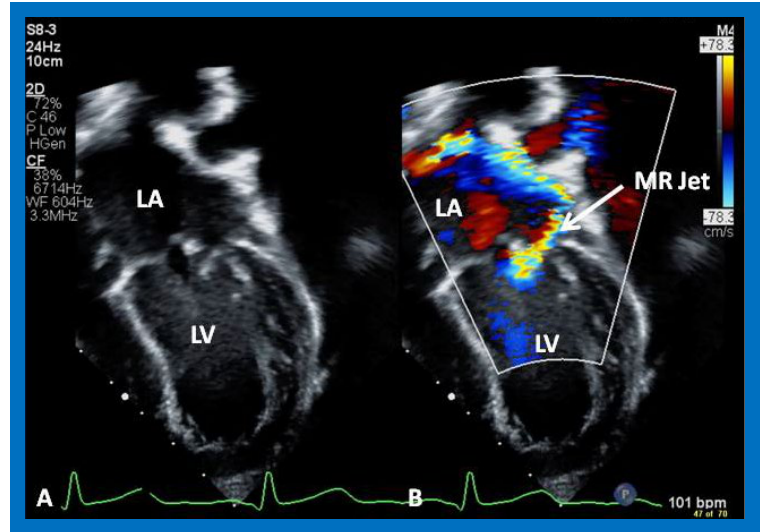
Figure 36. Selected video frames from apical four chamber view demonstrating dilated left atrium